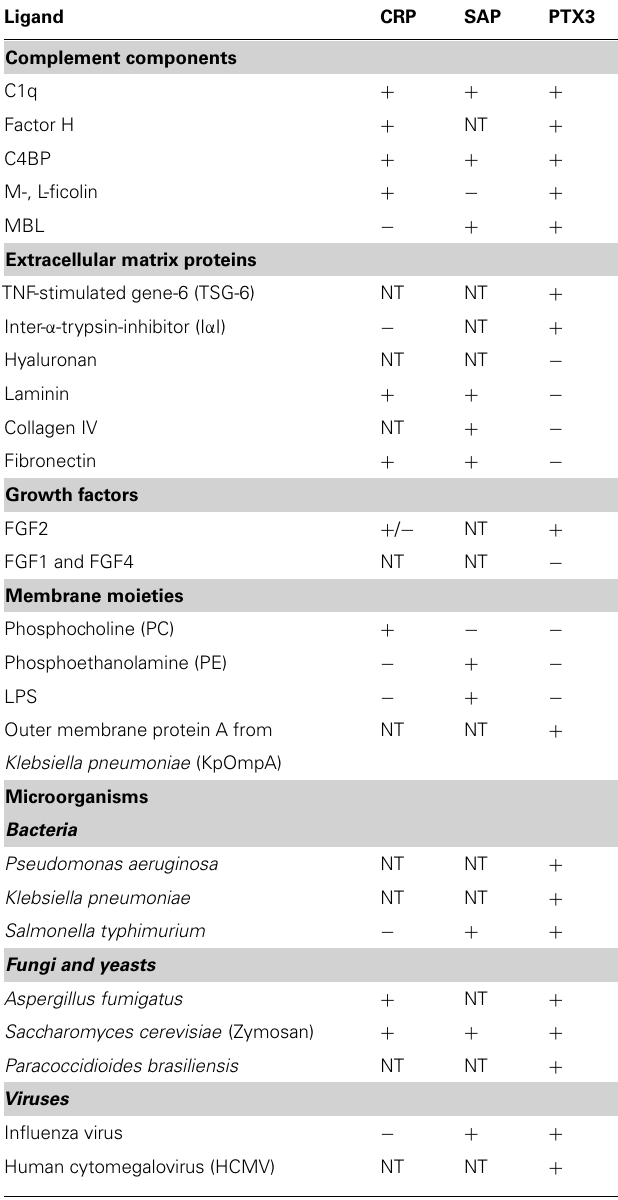
Table 1 | Ligand specificity of CRP, SAP, and